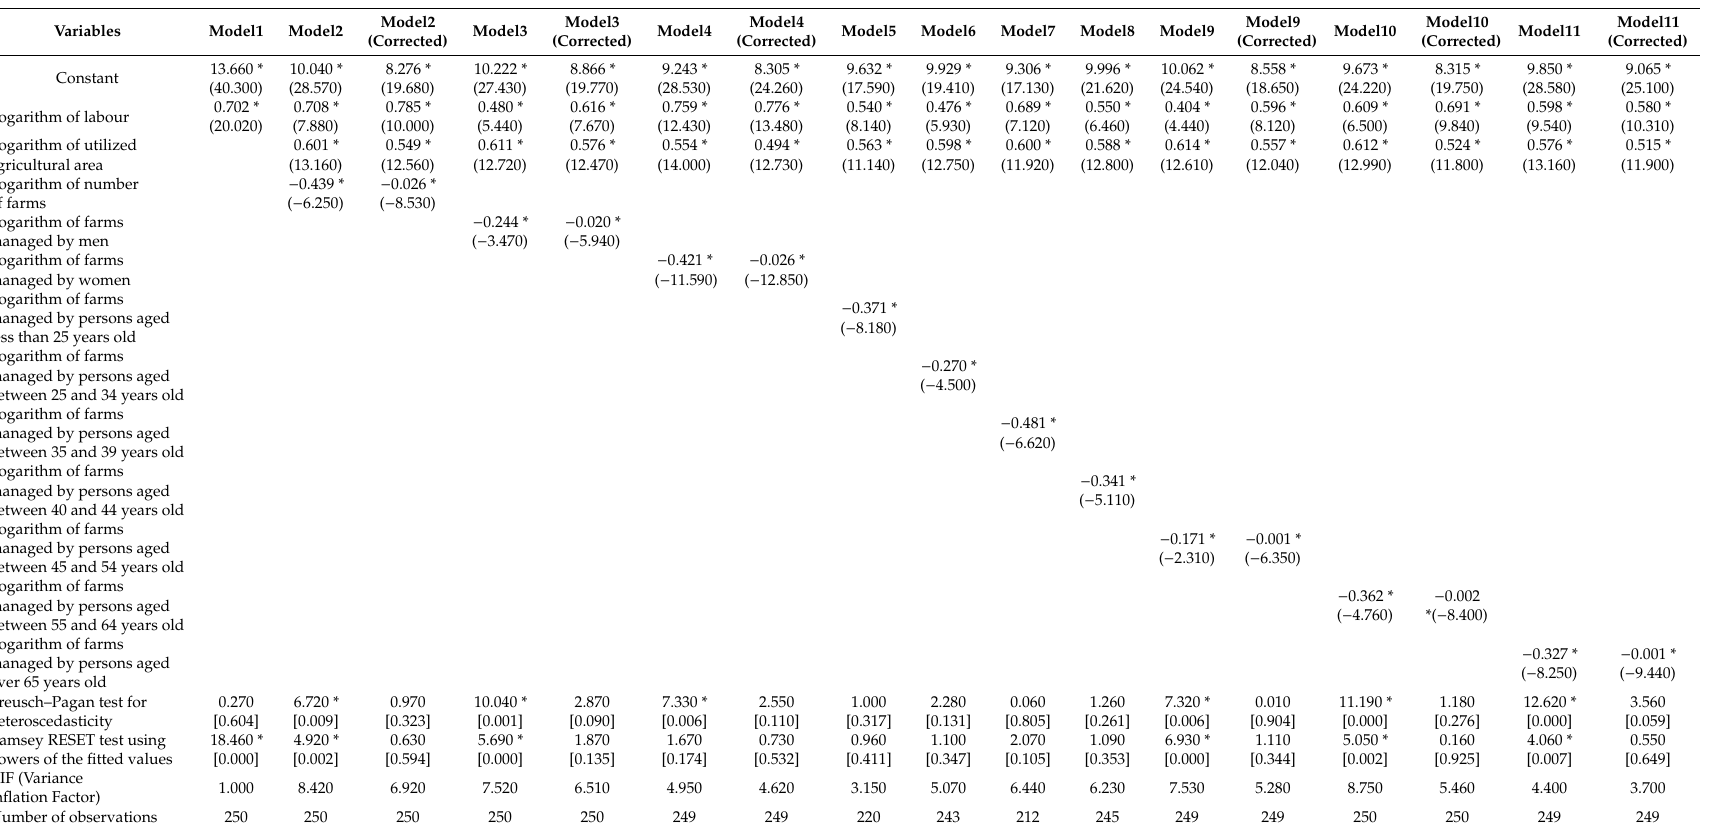
Table 3. Cross-section results based on the production function model (standard output logarithm as dependent